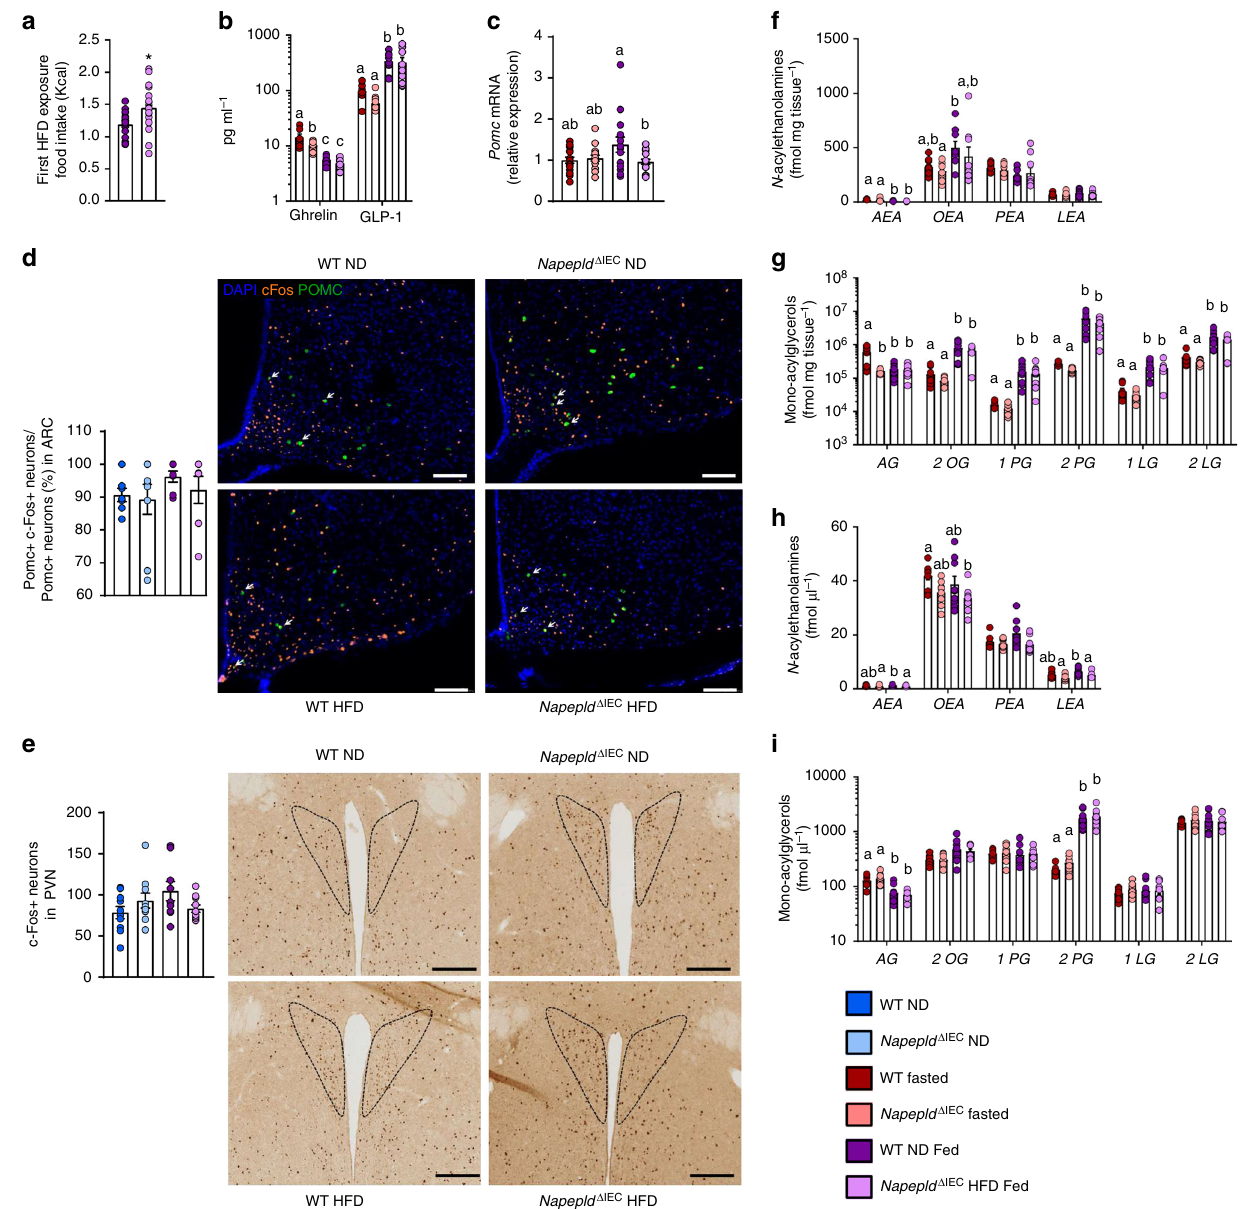
Fig. 3 Hyperphagia in Napepld Δ IEC mice is linked to alterations in Pomc neurons, NAE, and mono-acylglycerols. a HFD intake (Kcal) ( n = 17). b Ghrelin and GLP-1 levels (pg ml -1 ) in the portal vein ( n = 7 – 9). c Relative mRNA expression of Pomc in the hypothalamus ( n = 15 – 17). d Percentage of Pomc and c-Fos positive neurons among Pomc positive neurons in the ARC ( n = 7 – 10) and representative images showing double IF-TSA staining in the ARC (bregma − 1,70 mm) (scale bar = 100 μ m), magni fi cation 20×. White arrows indicate activated neurons (c-Fos positive, in orange) expressing POMC (in green). e c-Fos positive neurons in the PVN ( n = 9 – 10) and representative bright fi eld images of c-Fos immunohistochemistry in the PVN (bregma − 0,58 mm) (scale bar = 200 µ m), magni fi cation 10×, black dashed line is delimiting the PVN. f N -acylethanolamines (fmol mg − 1 ) measured in the jejunum ( n = 7 – 9) using Shimadzu 8050 triple quadrupole mass spectrometer. g mono-acylglycerols (AG = 1AG + 2AG) (fmol mg − 1 ) measured in the jejunum ( n = 7 – 9). h N -acylethanolamines (fmol μ l − 1 ) measured in the portal vein ( n = 7 – 9). i Mono-acylglycerols (AG = 1AG + 2AG) (fmol μ l − 1 ) measured in the portal vein ( n = 7 – 9) using Shimadzu 8050 triple quadrupole mass spectrometer. a – c and g – j are measured in WT and Napepld Δ IEC mice either fasted or after 4 h of HFD intake, d – f are measured in WT and Napepld Δ IEC mice after 1 h of ND or HFD intake. Data in a and c correspond to the results of two independent experiments. Dark blue: WT ND mice, light blue: Napepld Δ IEC ND mice, red: WT fasted mice, salmon: Napepld Δ IEC fasted mice, purple: WT HFD mice and pink: Napepld Δ IEC HFD mice. Data are presented as the mean ± s.e.m. Asterisk (*) indicates a signi fi cant difference versus WT HFD ( P < 0.05) according to Mann – Whitney test. Data with different superscript letters are signi fi cantly different ( P < 0.05) according to regular two-way